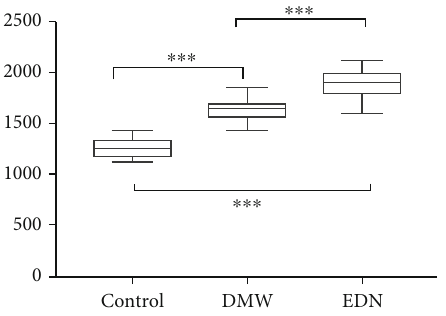
Figure 1: Box plot of baPWV measurements in the three groups. baPWV was signi fi cantly higher in patients with diabetes (with or without DN) than in the control group. Patients with DN had a signi fi cantly higher baPWV than diabetes patients without nephropathy. ∗∗∗ P < 0 : 001 .